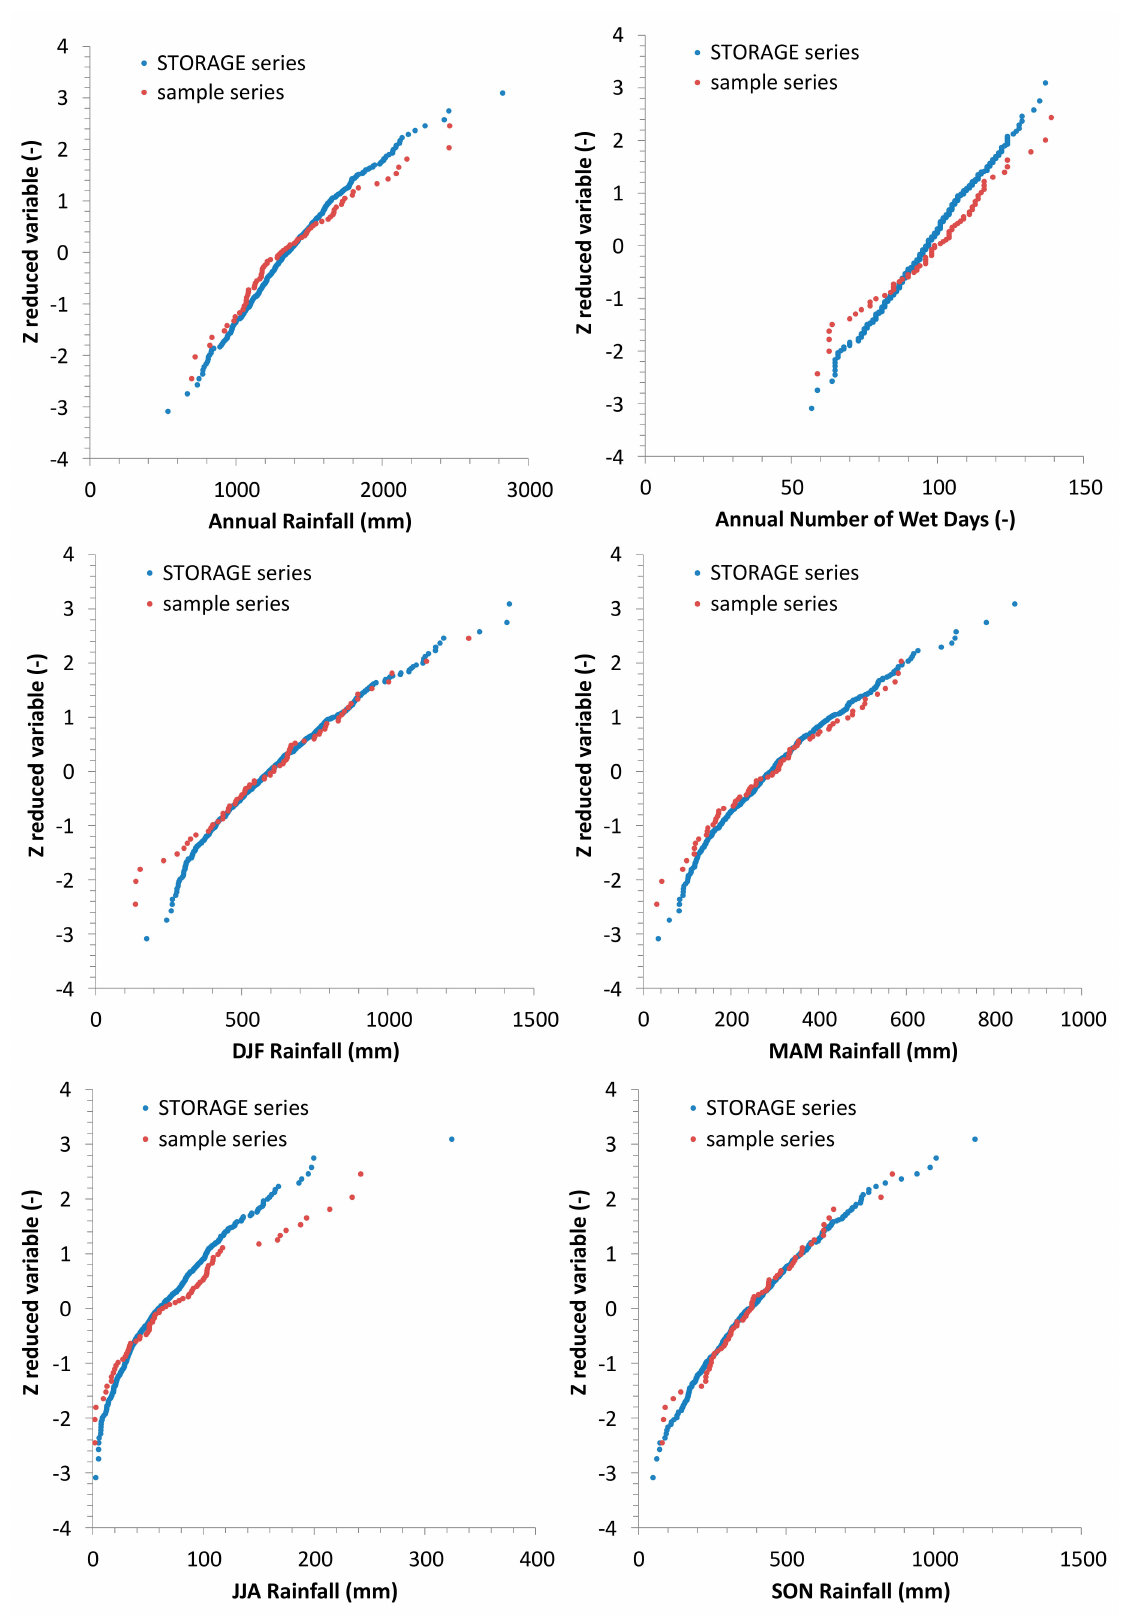
Figure 17. Montalto Uffugo rain gauge: Gaussian probabilistic plots, showing the comparison among synthetic and observed series, regarding annual and seasonal rainfall, and annual number of wet